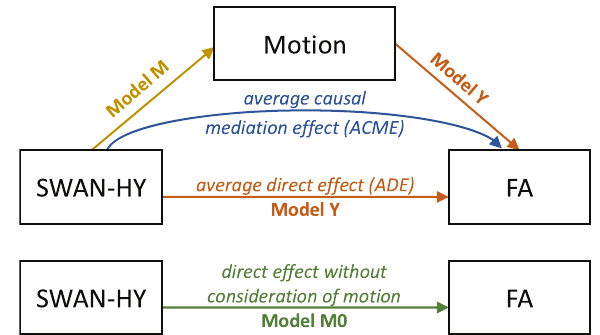
Fig. 3 Causal mediation analysis design. Model Y (orange) captures the average direct effect (ADE) of SWAN-HY on FA. Model M (yellow) re fl ects the effect of SWAN-HY on motion regardless of FA. The indirect effect of SWAH-HY on FA through the mediation of motion is the average causal mediation effect (ACME) (blue). Model M0 (green) captures the relationship of SWAN-HY on FA disregard- ing any effect of motion. SWAN-HY, Strengths and Weaknesses Assessment of Normal Behavior Rating Scale for ADHD Hyperactivity Score; FA, fractional